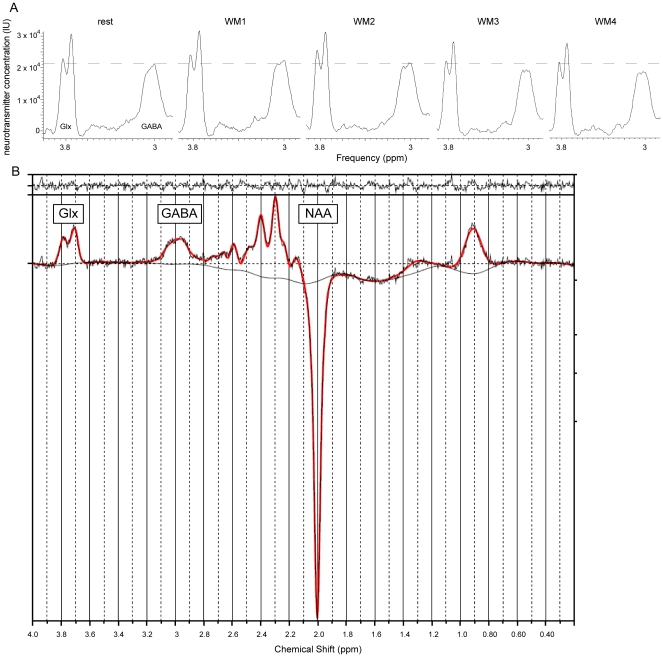
Representative MEGA-PRESS spectra.(A) Averaged MEGA-PRESS spectra (averaged across the subject group) acquired at rest (left) and during the WM task. The GABA peak at 3.0 ppm appears to increase between the resting spectrum and the first WM spectrum, and then decrease during performance of the WM task (panels 2-5). The dashed line marks the resting state peak. Glx: glutamate + glutamine concentration, GABA: gamma-aminobutyric acid, NAA: N-acetylaspartate, IU: institutional units. (B) LCModel output for a single subject: the fit is shown in red, superimposed on the edited spectrum (in black). The top panel shows the residuals between the MRS data and the spectral fit.